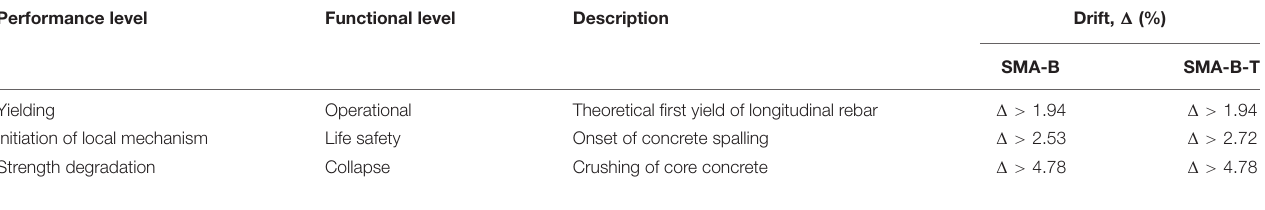
TABLE 5 | Damage states of SMA-RC bridge bents in terms of performance